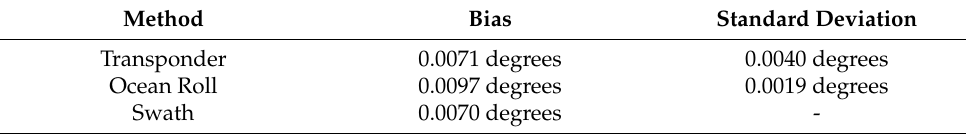
Table 2. Comparison of the roll bias results for Baseline-C.